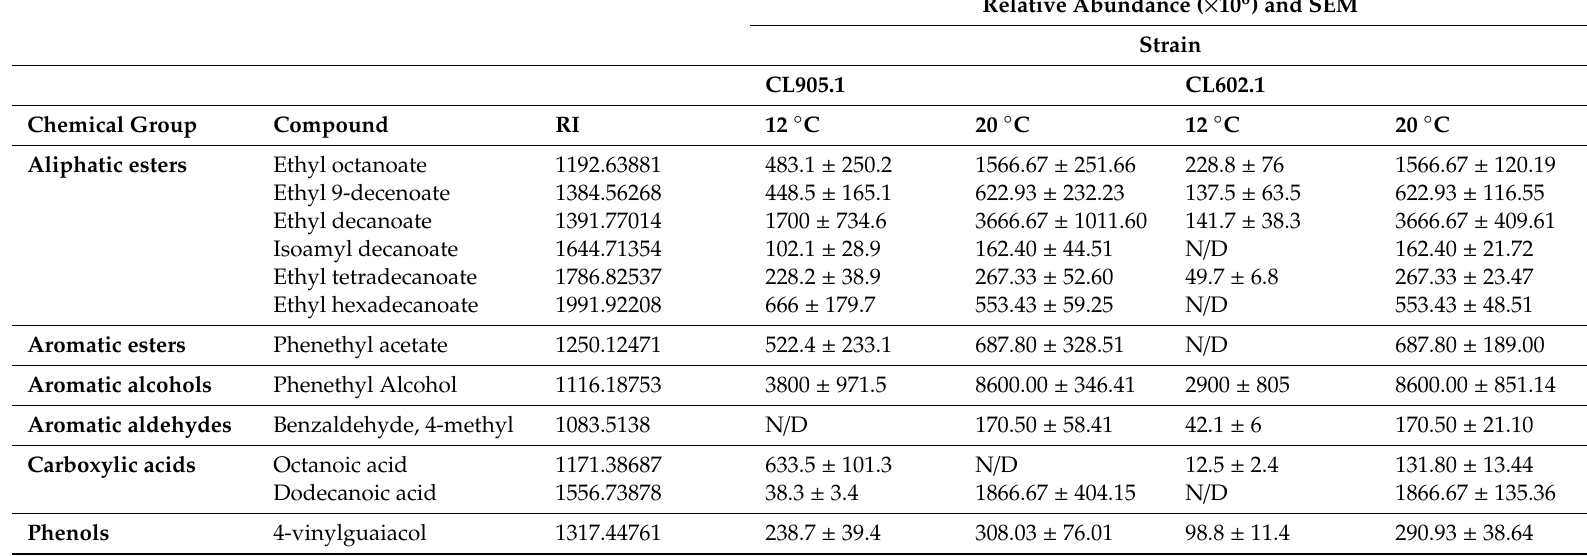
Table 2. Main Volatile Compounds detected in CL905.1 and